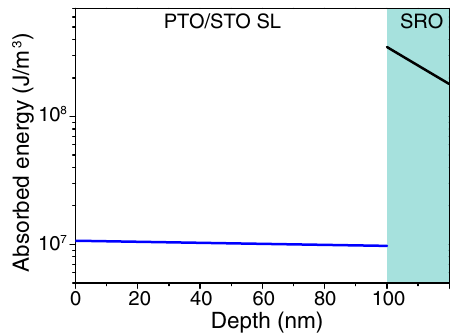
FIG. 5. Absorbed optical energy per unit volume in the SL/SRO thin-film heterostructure.